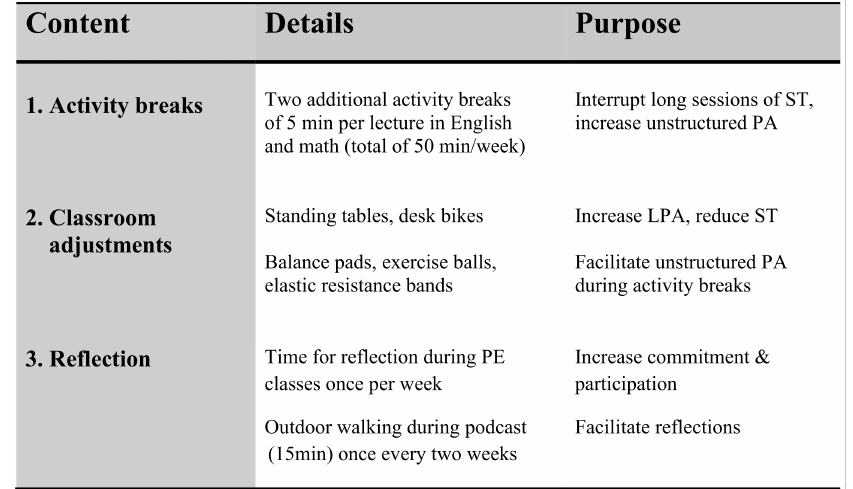
Figure 1. Overview of the Intervention Content. Abbreviations; PA = physical activity, LPA = light physical activity, ST = sedentary time, PE = physical